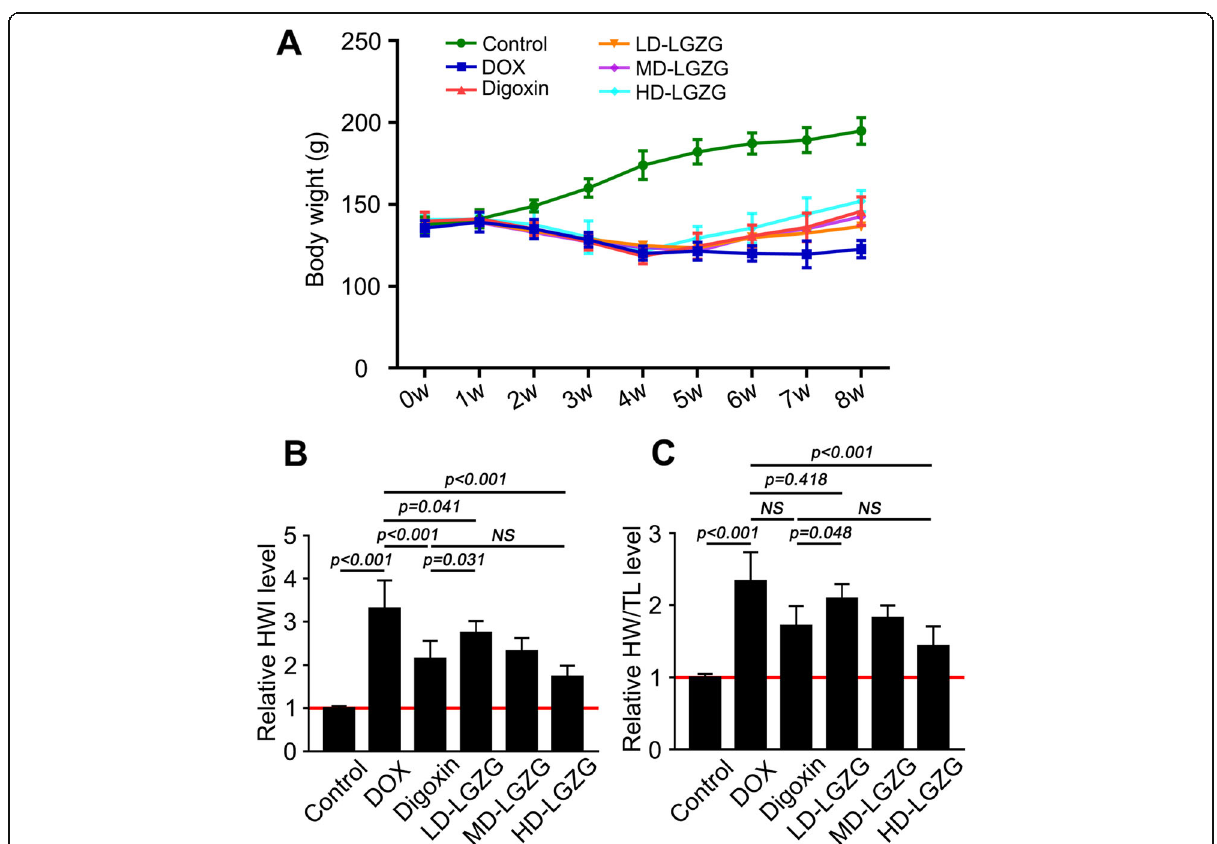
Fig. 2 LGZG prevented aggravation of DOX-induced HF. ( a ) Body weight. Effect of LGZGT on HWI and the HW/TL ratio is shown in ( b ) and ( c ), respectively. Values were normalized to the control group. Data are mean ± SEM, n = 8. NS, not